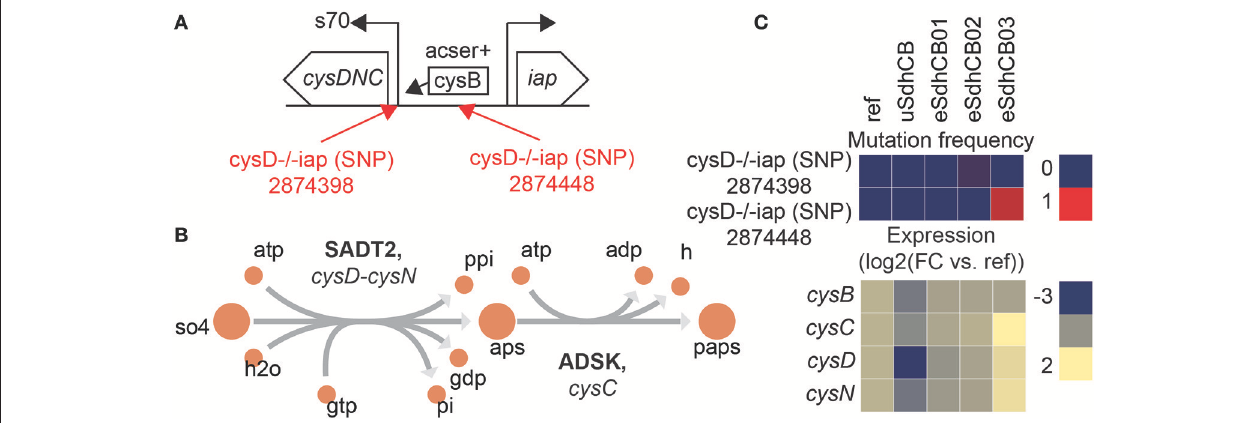
FIGURE 7 | Intergenic mutations that enhance expression of the cysDNC operon in eSdhCB strains. (A) Operon diagram of the cysDNC and iap operons. cysDNC is positively regulated by the transcription factor CysB, and encodes enzymes involved in sulfate reduction. Mutations are annotated in Red. The 2874398 SNP is located at the RNAP binding site. The 2874448 SNP is located at the CysB binding site. (B) Network schematic of the reactions encoded by cysD , cysN , and cysC . cysD and cysN encode subunits of sulfate adenylyltransferase (SADT2) which converts sulfate (so4) to adenosine 5 ′ -phosphosulfate (aps). cysC encodes adenylyl-sulfate kinase (ADSK) which converts aps to 3 ′ -phosphoadenylyl-sulfate (paps). (C) Mutation frequency and expression levels for genes involved in expression of the cysDNC operon. Note that eSdhCB03 has significantly higher expression levels of cysDNC than all other